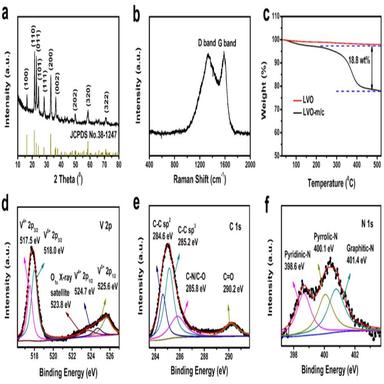
(a) XRD pattern, (b) Raman spectrum, (c) TGA analysis, (d) V 2p, (e) C 1s, (f) N 1s XPS spectra of LVO-m/c.